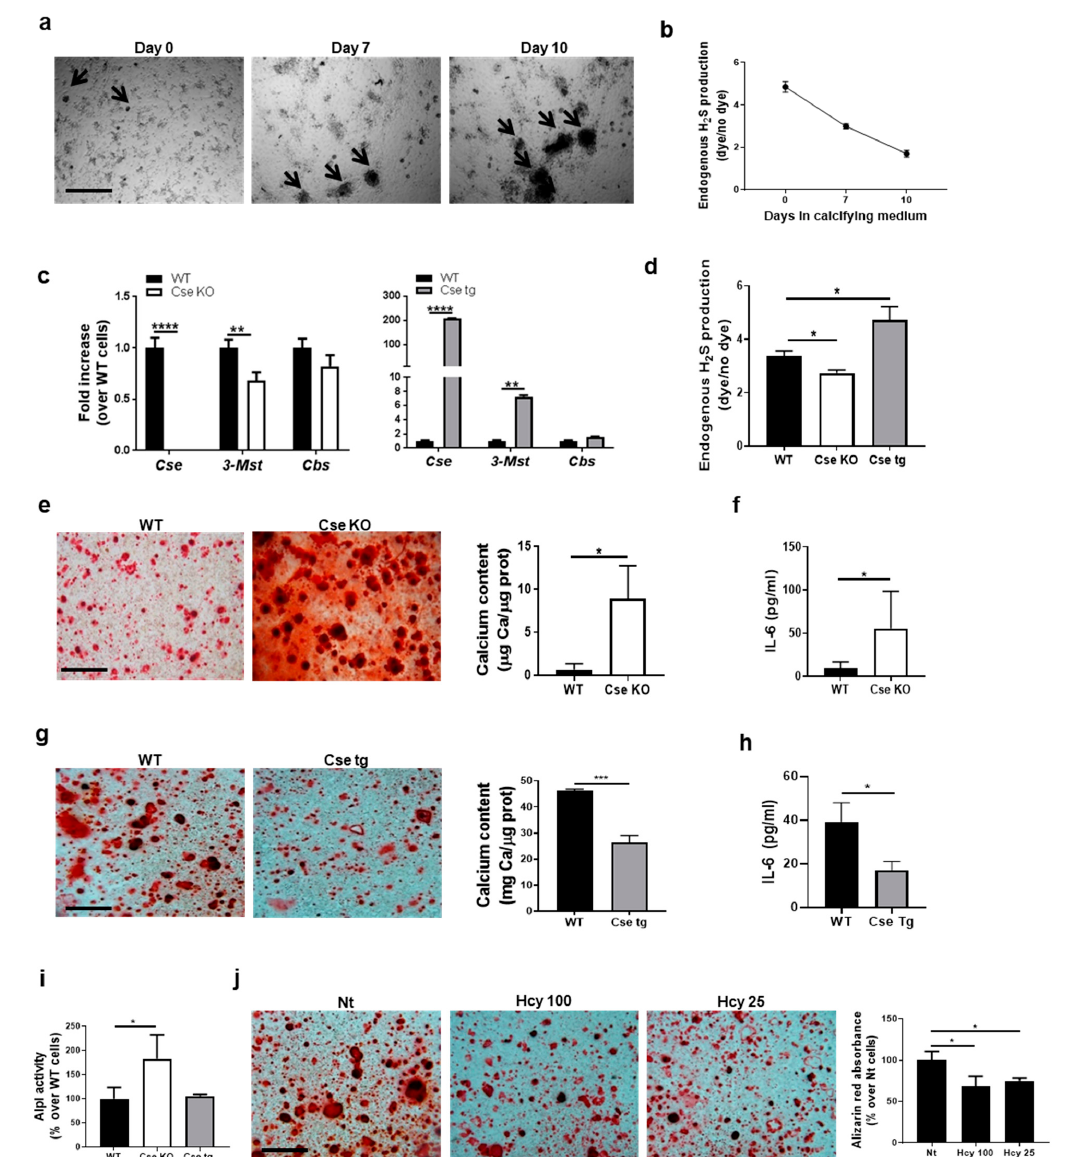
Figure 2. Cse-generated H 2 S regulates calcification and IL-6 secretion in chondrocytes. ( a ) Chondrocytes cultured in calcifying medium for 0, 7 and 10 days. Black arrows indicate calcium-containing crystals. Scale bars 500 µ m. ( b ) FACS analysis by P3 probe of endogenous H 2 S production by chondrocytes in ( a ). ( c ) qRT-PCR analysis of the indicated genes in WT, Cse KO and Cse tg chondrocytes, at basal level. WT cells are considered as reference (=1). ( d ) FACS analysis by P3 probe of endogenous H 2 S production by WT, Cse KO and Cse tg chondrocytes, at basal level. ( e ) Alizarin red staining of WT and Cse KO chondrocytes cultured in calcification medium for 14 days. Scale bars 500 µ m. Graph represents calcium content in the cell monolayer, expressed in mg Ca/ µ g protein. ( f ) IL-6 secretion by WT and Cse KO chondrocytes in ( f ). ( g ) Alizarin red staining of WT and Cse tg chondrocytes cultured in calcification medium for 14 days. Scale bars 500 µ m. Graph represents calcium content in the cell monolayer, expressed in mg Ca/ µ g protein. ( h ) IL-6 secretion by WT and Cse tg chondrocytes in ( h ). ( i ) Basal Alpl activity in WT, Cse KO and Cse tg chondrocytes, expressed as % over WT cells. ( j ) Alizarin red staining and quantification in WT chondrocytes cultured in calcification medium for 14 days and treated with different concentrations of homocysteine (Hcy 100 µ M and Hcy 25 µ M). Scale bars 500 µ m. Graph represents alizarin red quantification in the cell monolayer, expressed in % over Nt cells. Statistics: * p < 0.05, ** p < 0.01, *** p < 0.001, **** p < 0.0001. Pictures represent triplicates from one experiment of three independent experiments. Graphs represent mean ± SD or triplicate samples from one experiment of three independent